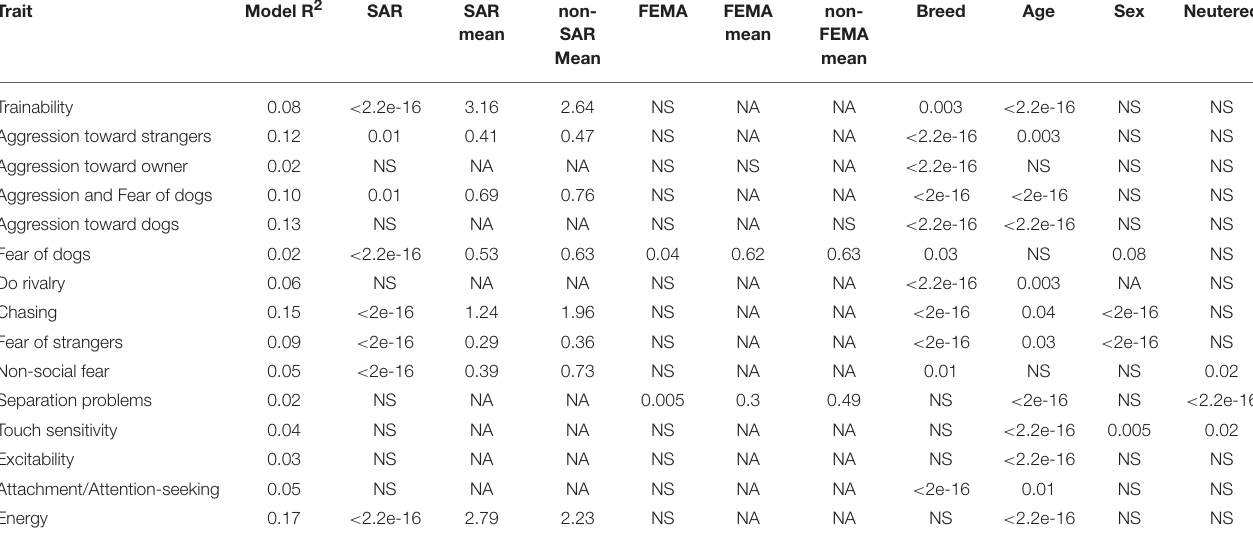
TABLE 3 | Final models for C-BARQ subscales ( NS = not significant at P < 0.05 in previous model in backward elimination). Trait